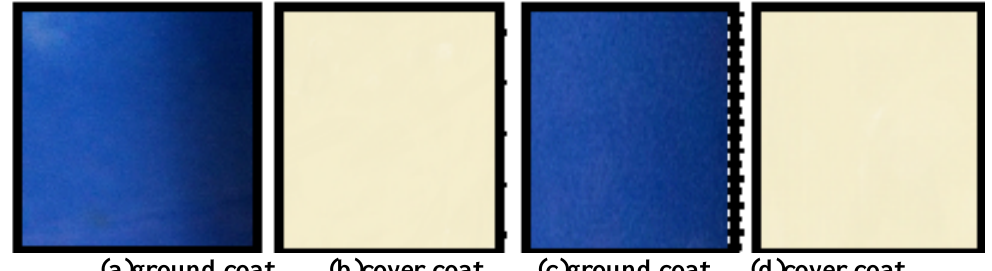
Fig. 3: Steel enameling (X200); (a, b) without addition antimony oxide, (c, d) by addition antimony